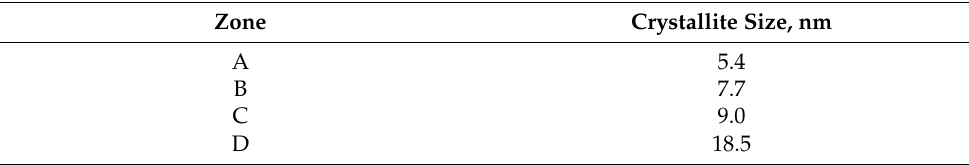
Table 2. Sizes of gahnite crystals are calculated by Scherrer’s